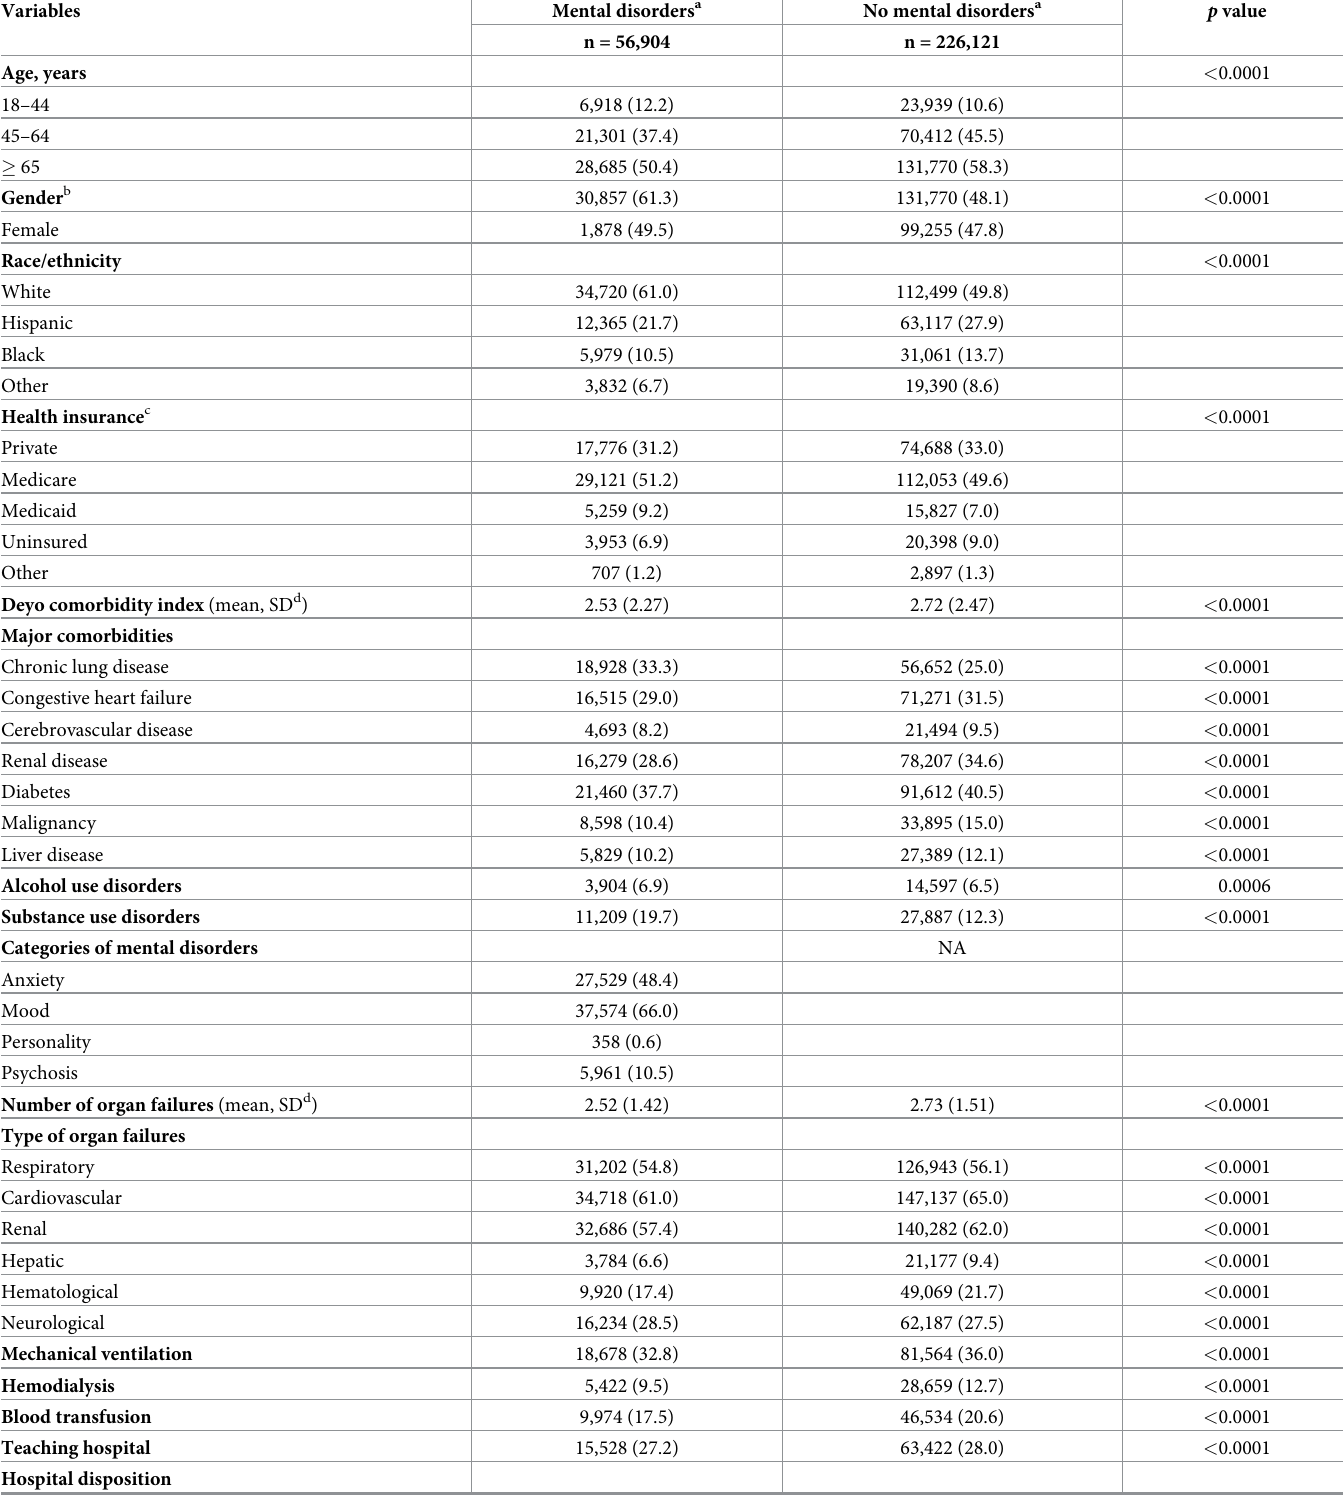
Table 1. The characteristics of septic hospitalizations with and without mental